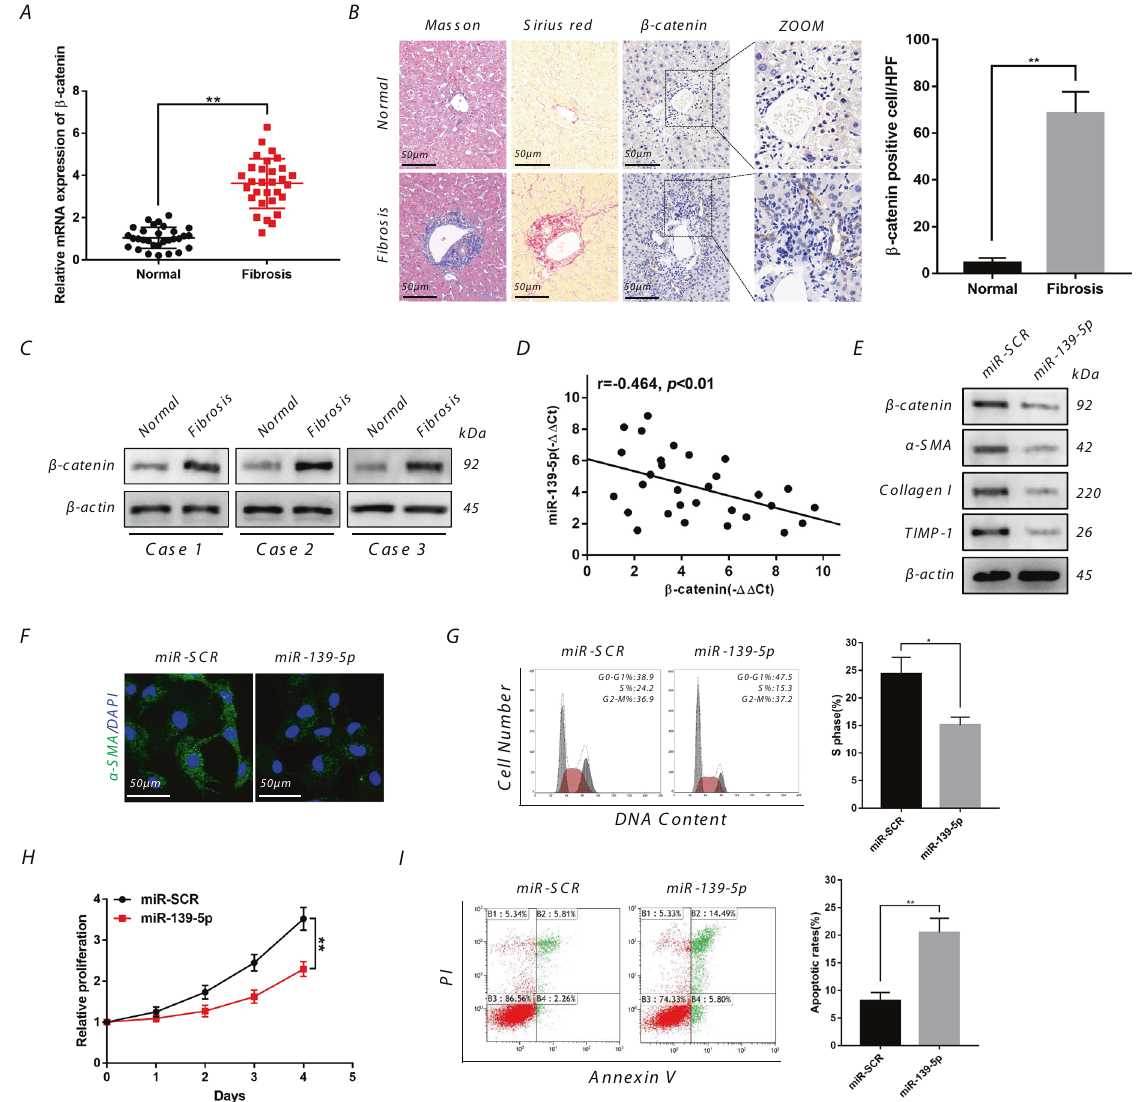
Fig. 3 β -catenin is overexpressed in fi brotic liver tissues and miR-139-5p upregulation suppresses β -catenin expression. A The mRNA expression level of β -catenin was upregulated in human fi brotic liver tissues. n = 30/group. B The sections of human liver tissues were treated with Masson staining, Sirius red staining and Immunohistochemical staining of β -catenin. n = 6/group, original magni fi cation×200. C The protein levels of β -catenin in normal or fi brotic liver tissues from patients were examined by western blotting. Representative of three experiments. D The correlation between the expression levels of β -catenin and miR-139-5p in patient fi brotic liver tissues was evaluated with Pearson ’ s correlation analysis, n = 30. E The protein levels of β -catenin, α -SMA, Collagen-I, and TIMP-1 in LX-2 cells infected with miR-139-5p mimics were detected by western blotting. Representative of three experiments. F Immuno fl uorescence staining for α -SMA (green) in LX-2 cells transfected with miR-139-5p mimics was analyzed by confocal laser microscopy. DAPI was used to stain nuclei, blue. Original magni fi cation×400, Representative of three experiments. G The cell-cycle distribution of LX-2 cells infected with miR-139-5p mimics was analyzed by fl ow cytometry. Representative of three experiments. H Proliferation of LX-2 cells infected with miR-139-5p mimics was analyzed by CCK8 assay. I The cell apoptosis of LX-2 cells infected with miR-139-5p mimics was analyzed by fl ow cytometry. Representative of three experiments. Graph represents mean ± SD. * P < 0.05, ** P <